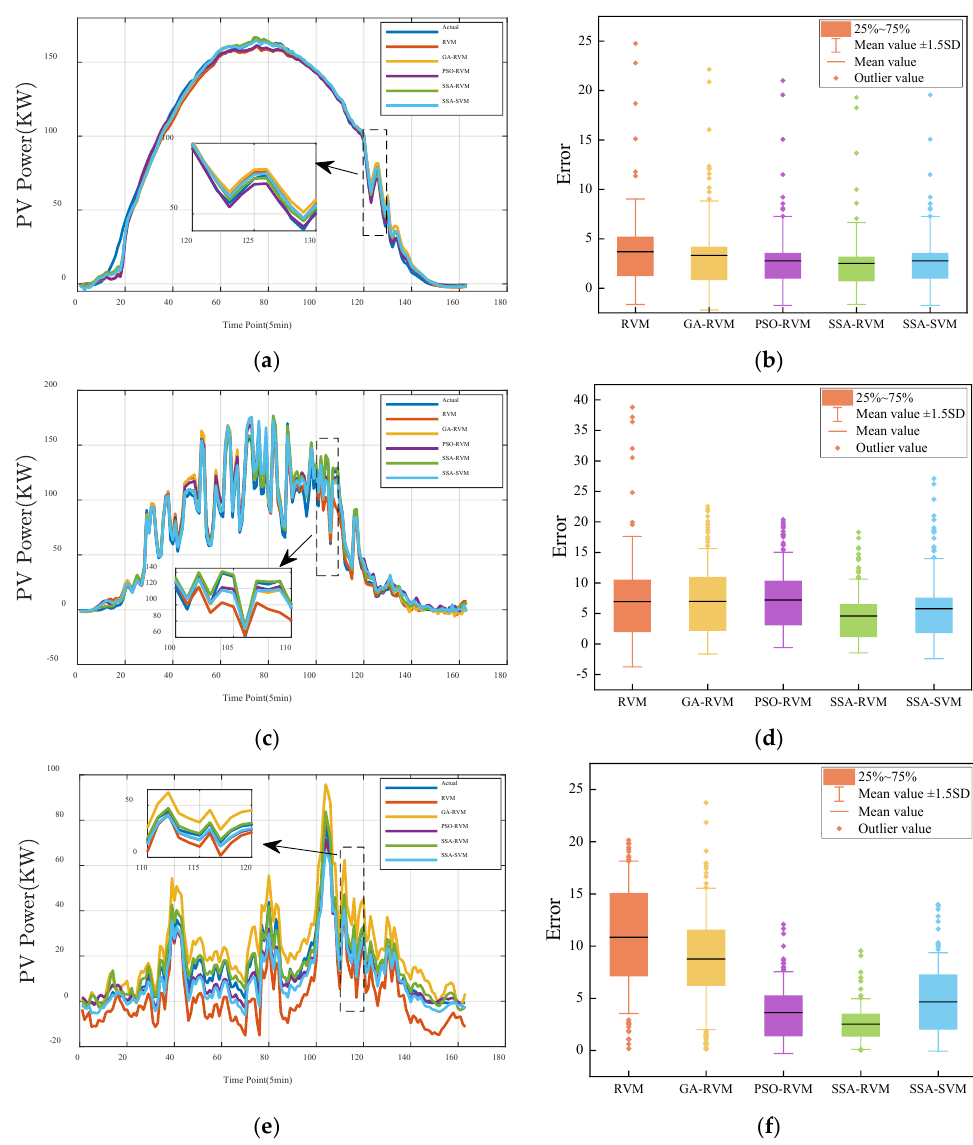
Figure 9. Results of different prediction methods under different weather types in spring: PV power prediction results in ( a ) sunny, ( c ) cloudy and ( e ) rainy, forecasting error in ( b ) sunny, ( d ) cloudy, and ( f )